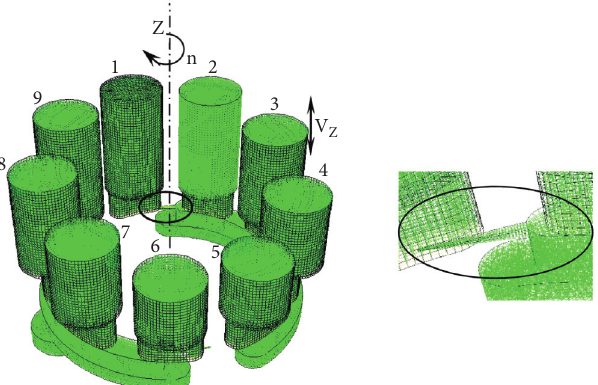
Figure 3: Internal flow channel mesh division of axial piston pump